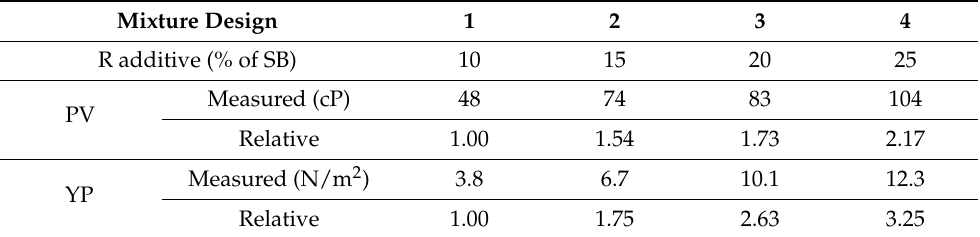
Table 3. Effects of different dosages of R additive on the rheological properties of the